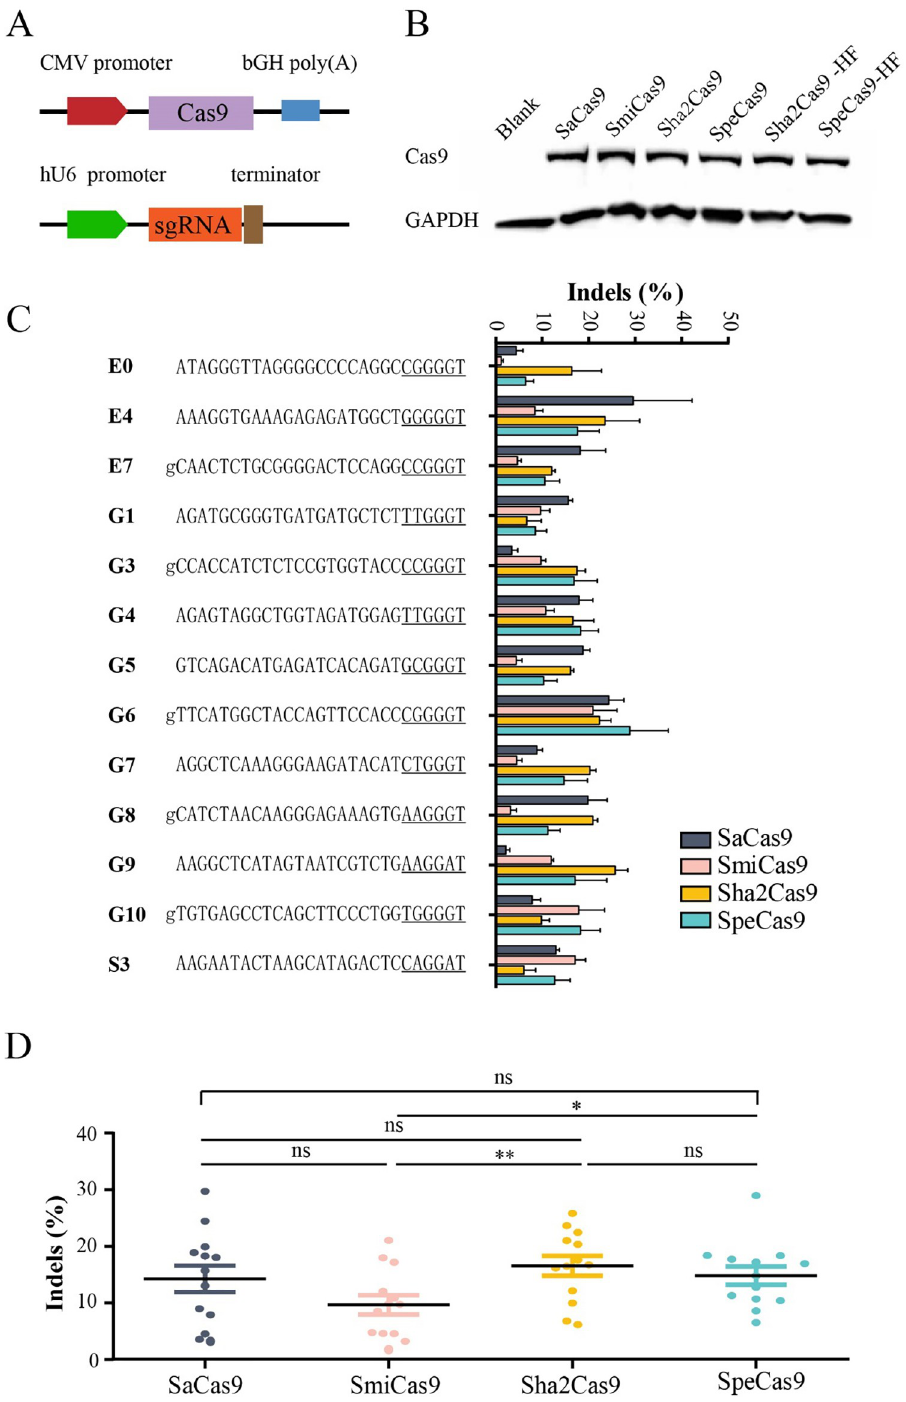
Fig 3. Genome editing for endogenous sites. ( A ) Schematic of the Cas9 expression constructs. ( B ) Protein expression level of Cas9s was measured by western blot. Cells without Cas9 transfection was used as a negative control. ( C ) Comparison of SaCas9, SmiCas9, Sha2Cas9, and SpeCas9 efficiency for genome editing at 13 endogenous loci. Additional “g” is added for U6 promoter transcription ( n = 3). Underlying data for all summary statistics can be found in S1 Data. ( D ) Quantification of editing efficiency for SaCas9, SmiCas9, Sha2Cas9, and SpeCas9. Underlying data for all summary statistics can be found in S1 Data.